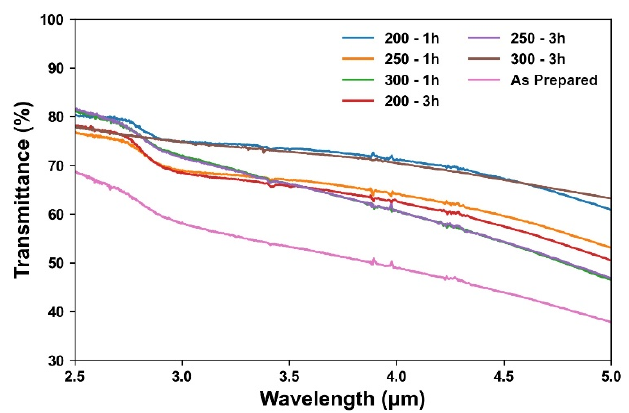
Figure 11. The transmission rate in mid-infrared band: annealing temperature and annealing time.